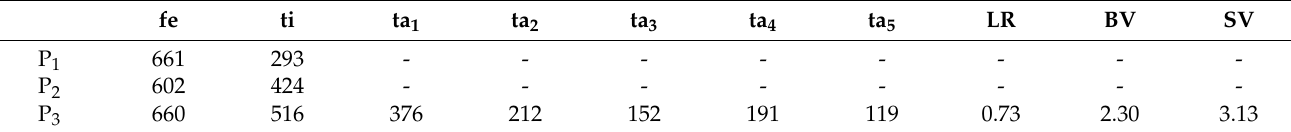
Table 3. Lengths (in µ m) and proportions of legs of Rheotanytarsus fluminis Kawai & Sasa 1985, adult male ( n =